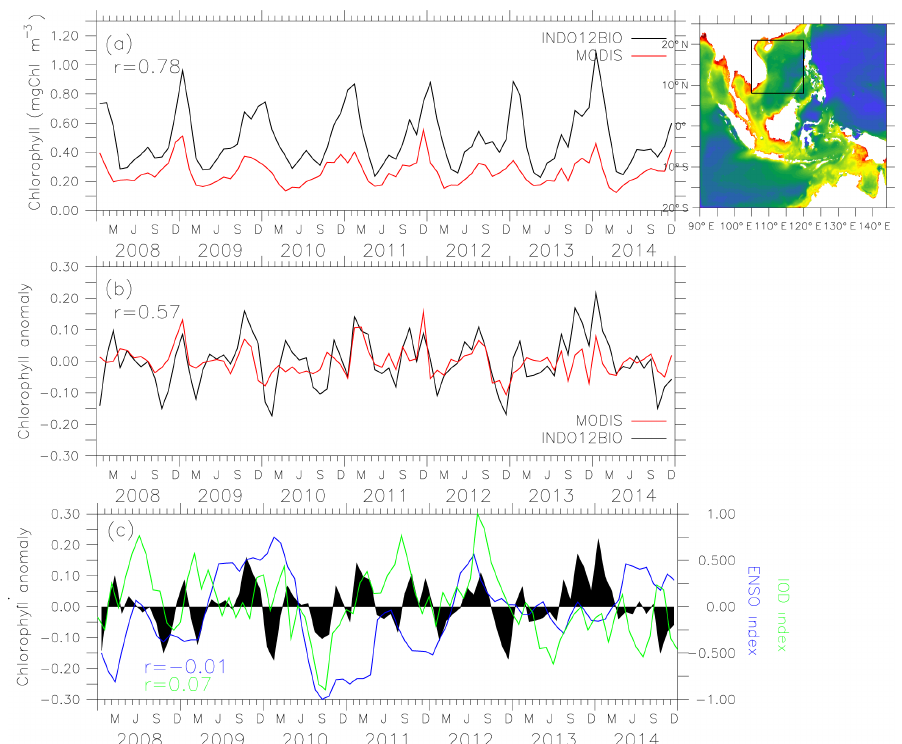
Figure 7. (a) Mean surface chlorophyll a concentrations and (b) its interannual anomalies (mgChlm − 3 ) over the South China Sea. INDO12BIO is in black and MODIS case-1 in red. Temporal correlation ( r ) between both time series is in black. (c) ENSO (blue) and IOD (green) phenomena are respectively represented by MEI and DMI indexes. Indexes were normalised by their maximum value in order to be plotted on the same axis. Interannual anomalies of simulated chlorophyll a are reminded in black. Temporal correlation ( r ) between the simulated chlorophyll a and ENSO (IOD) is indicated in blue